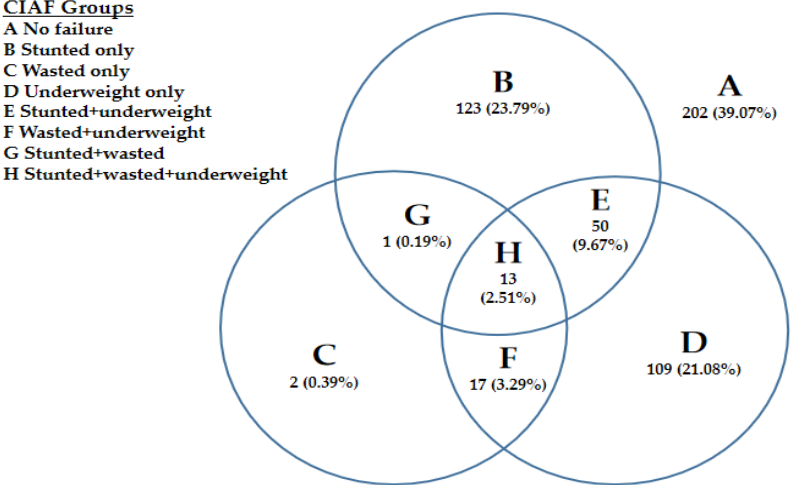
Figure 6. overall malnutrition prevalence (multiple anthropometric failures) according to the Sub- groups of CIAF classification.